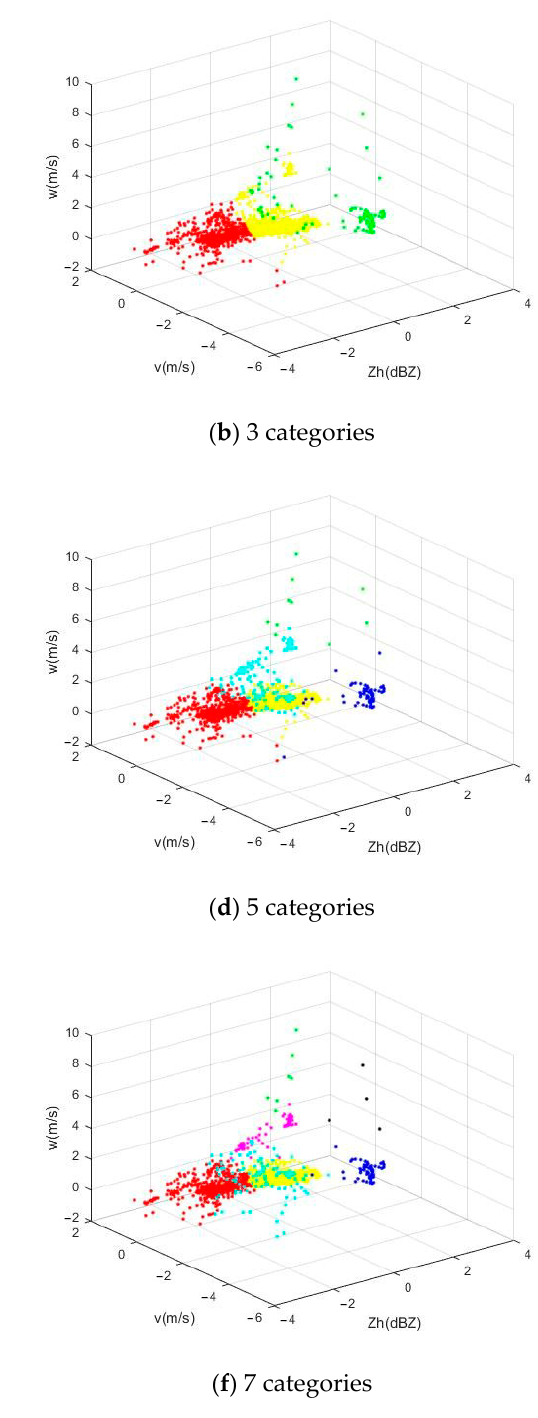
Figure 2. Radar data clustering analysis. From ( a – f ), the number of clusters increases from two to seven, respectively. In ( a ), red is category A and green is category B. After the number of categories is increased, the color and category number remain unchanged, and the newly added color is a new category (category C to category G).